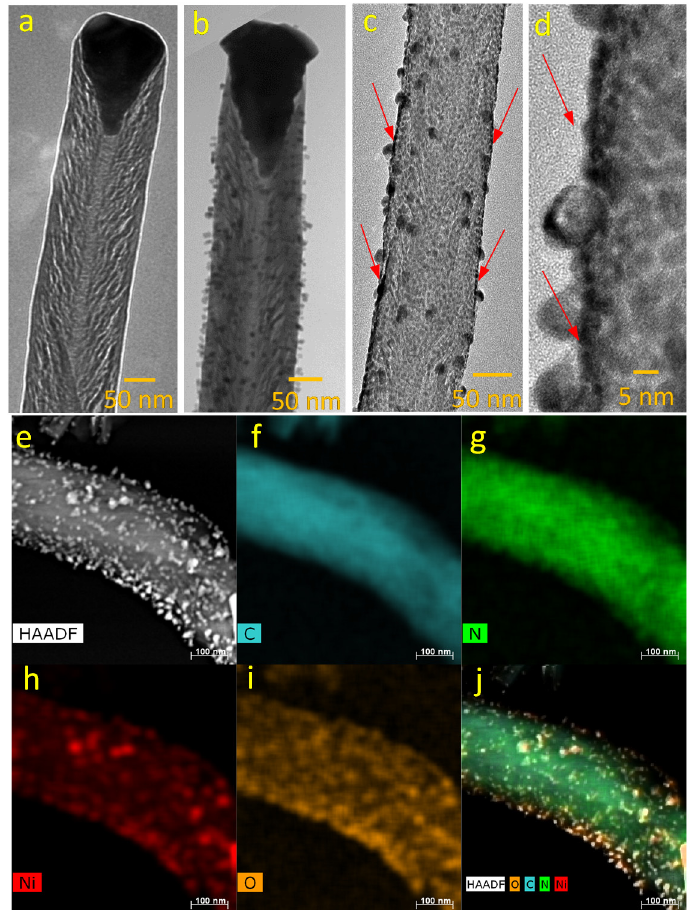
Figure 1. TEM image of bare VACNF ( a ) before and ( b ) after plasma annealing for 5 min at 550 °C. TEM image of Pt/N-VACNF PA 5 min (43.0 µg/cm 2 ) at ( c ) low and ( d ) high magnification. The red arrow indicates the Pt NPs deposited on the sidewalls; ( e ) HAADF-STEM image and ( f – j ) STEM-EDS elemental mapping of N-VACNF PA 15 min.